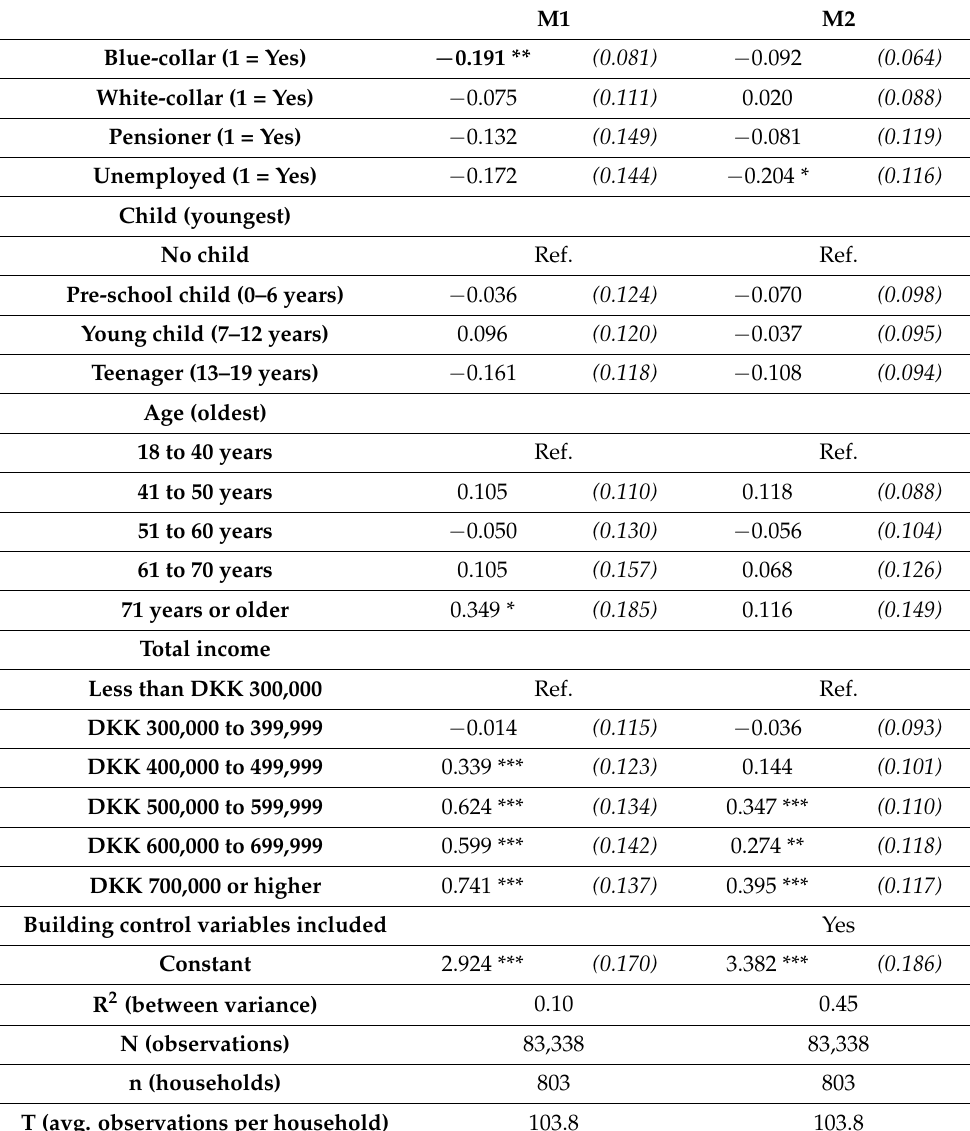
Table 4. Between-effect panel regression model for morning peak (5:00–9:00). Complete table